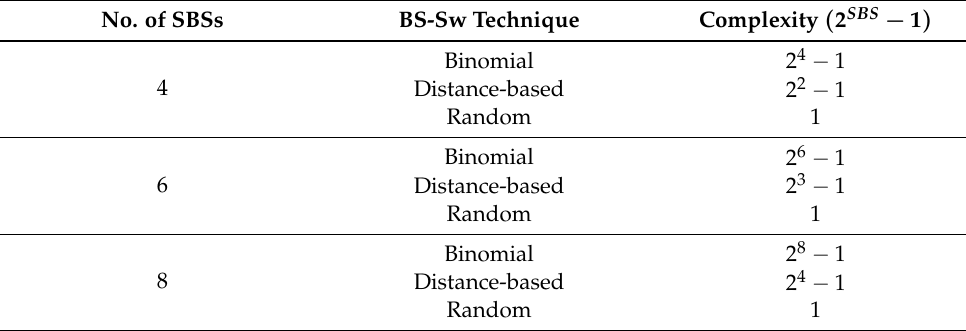
Table 5. Computational complexity of the proposed BS-Sw techniques.